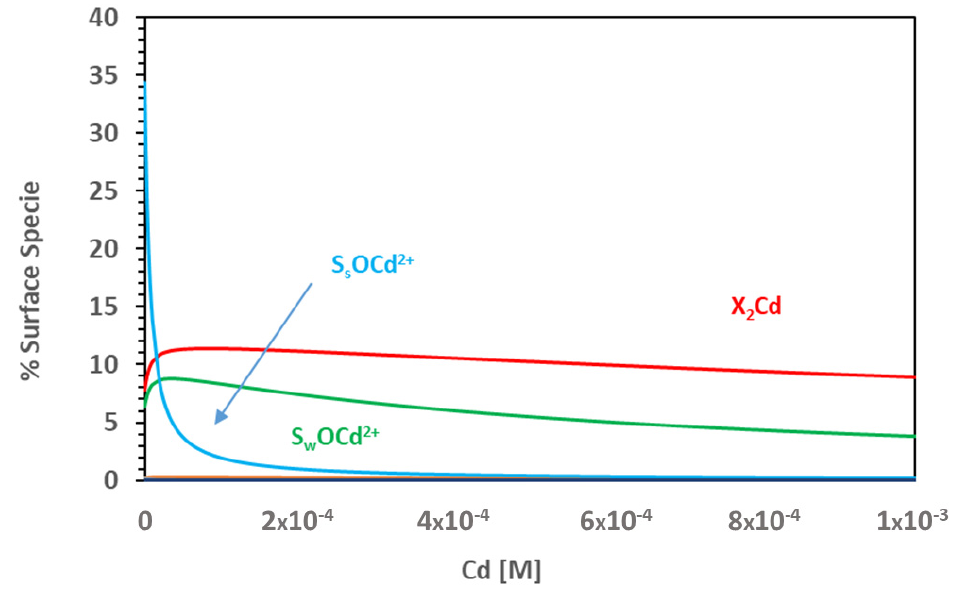
Figure 5. Percentage of surface species formed as a function of Cd concentration. 0.1 M NaClO 4 and pH = 5.1.